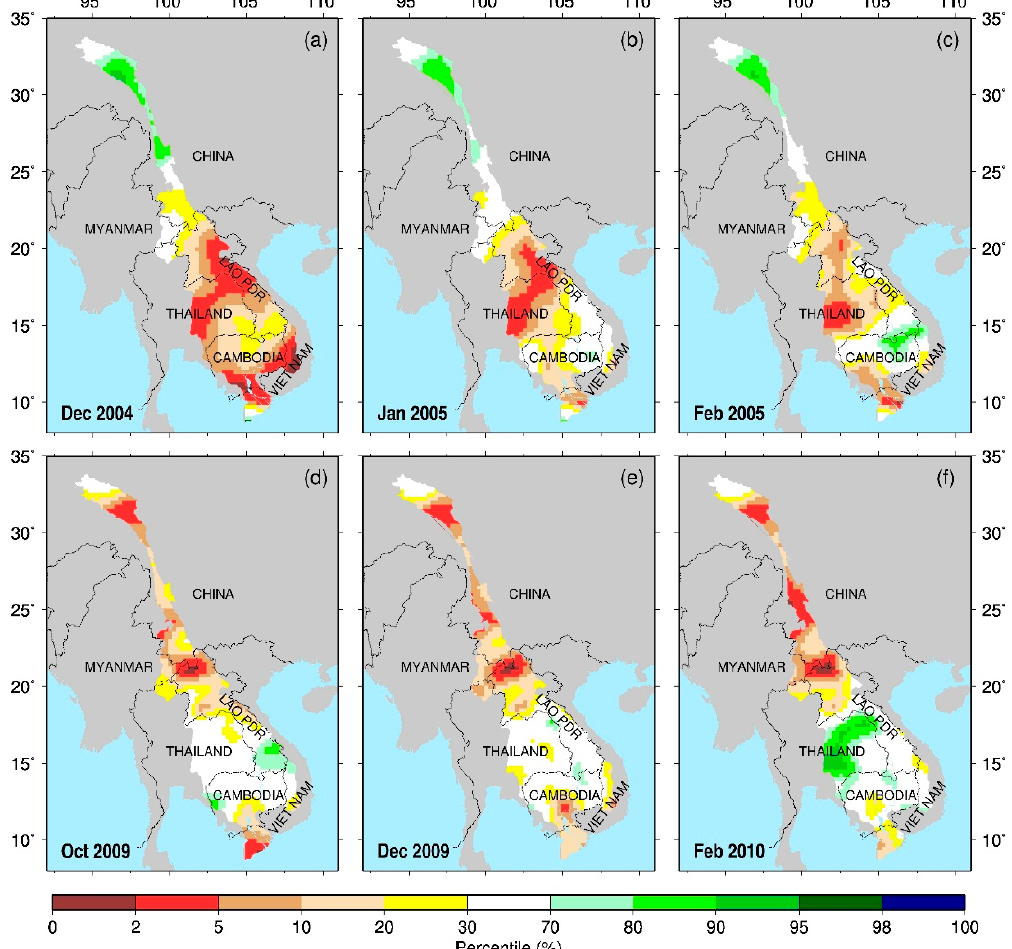
Figure 6. Monthly drought conditions (expressed as SM percentile) estimated from the 60-year VIC retrospective simulation driven by the PGF forcing data in three typical months during the 2004/05 drought ( a – c ) and the 2009/10 drought ( d – f